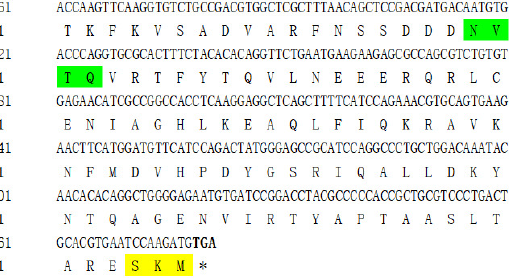
Figure 2. The nucleotide and deduced amino acid sequence of AdCAT (Catalase from Yangtze sturgeon). The catalase proximal active-site signature domain is marked by single underlining, the catalase proximal heme-ligand signature domain is marked by double underlining, the N- glycosylation site is highlighted in green, and the peroxisome targeting signal is highlighted in yellow, * indicates a stop codon.